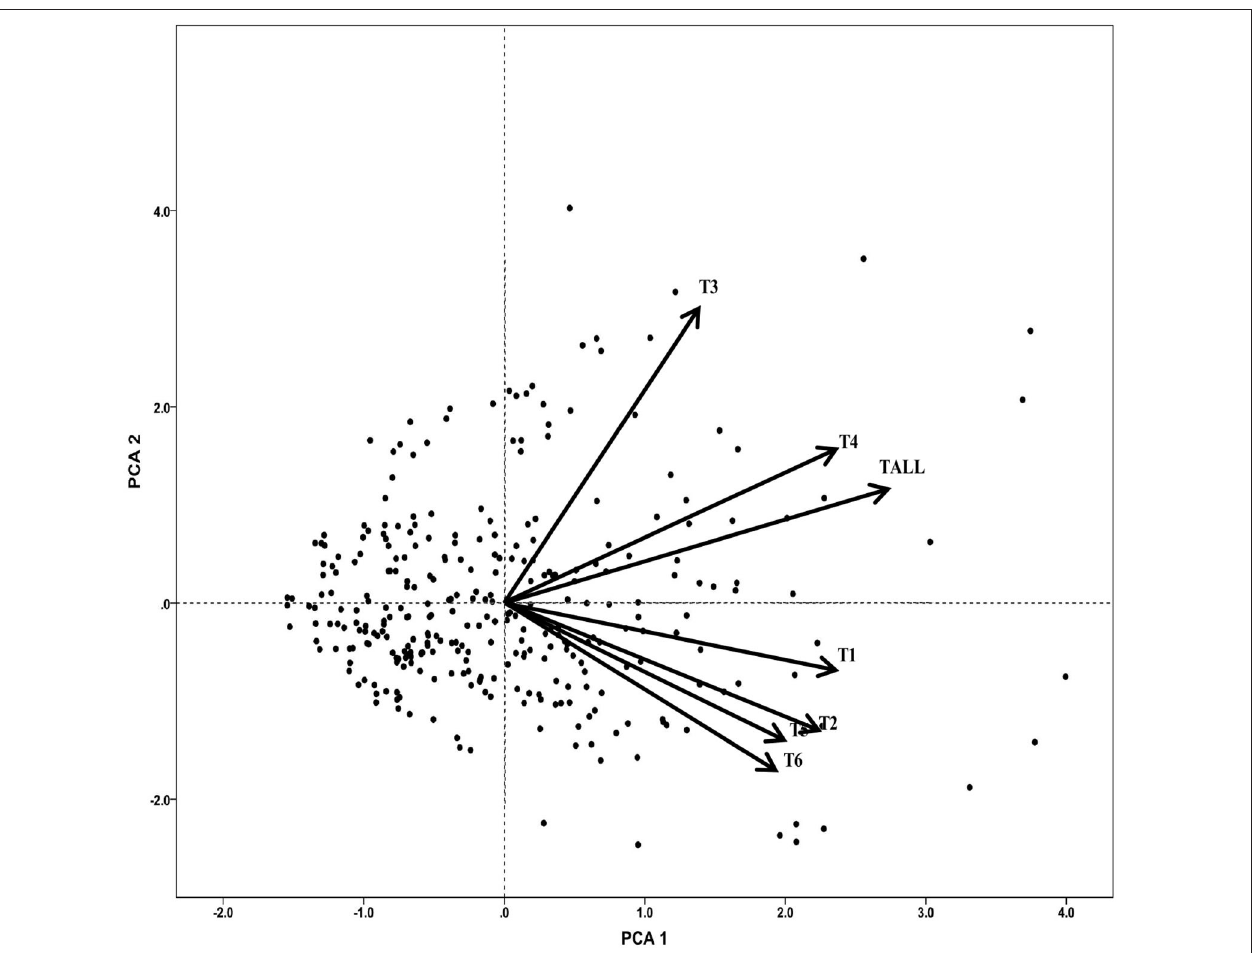
FIGURE 1 | Principal component analysis of triterpenoids of C. paliurus germplasm. T1, arjunolic acid; T2, cyclocaric acid B; T3, pterocaryoside B; T4, pterocaryoside A; T5, hederagenin; T6, oleanolic acid; Tall, total